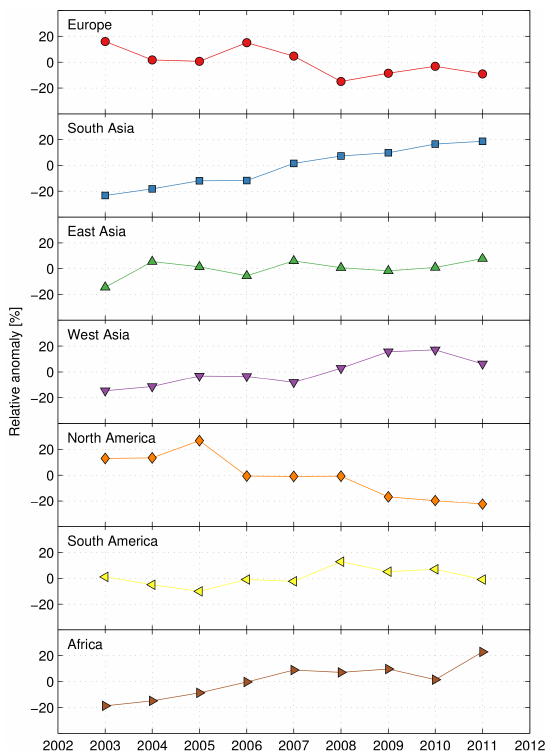
Figure 6. Interannual variability of NO 2 over large urban agglom- erations, averaged by region. To facilitate an easier comparison be- tween regions, the plot shows the average of the relative anomaly (given in %) of each sites’ time series within a given region. The anomalies were computed relative to the long-term mean absolute NO 2 concentration at each